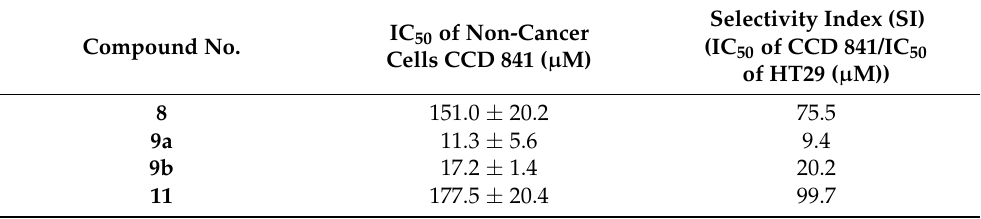
Table 2. The selectivity index (SI) which represents IC 50 for normal cell line (CCD 841)/IC 50 for cancerous cell line (HT29) after 72 h of exposure to the tested compounds.